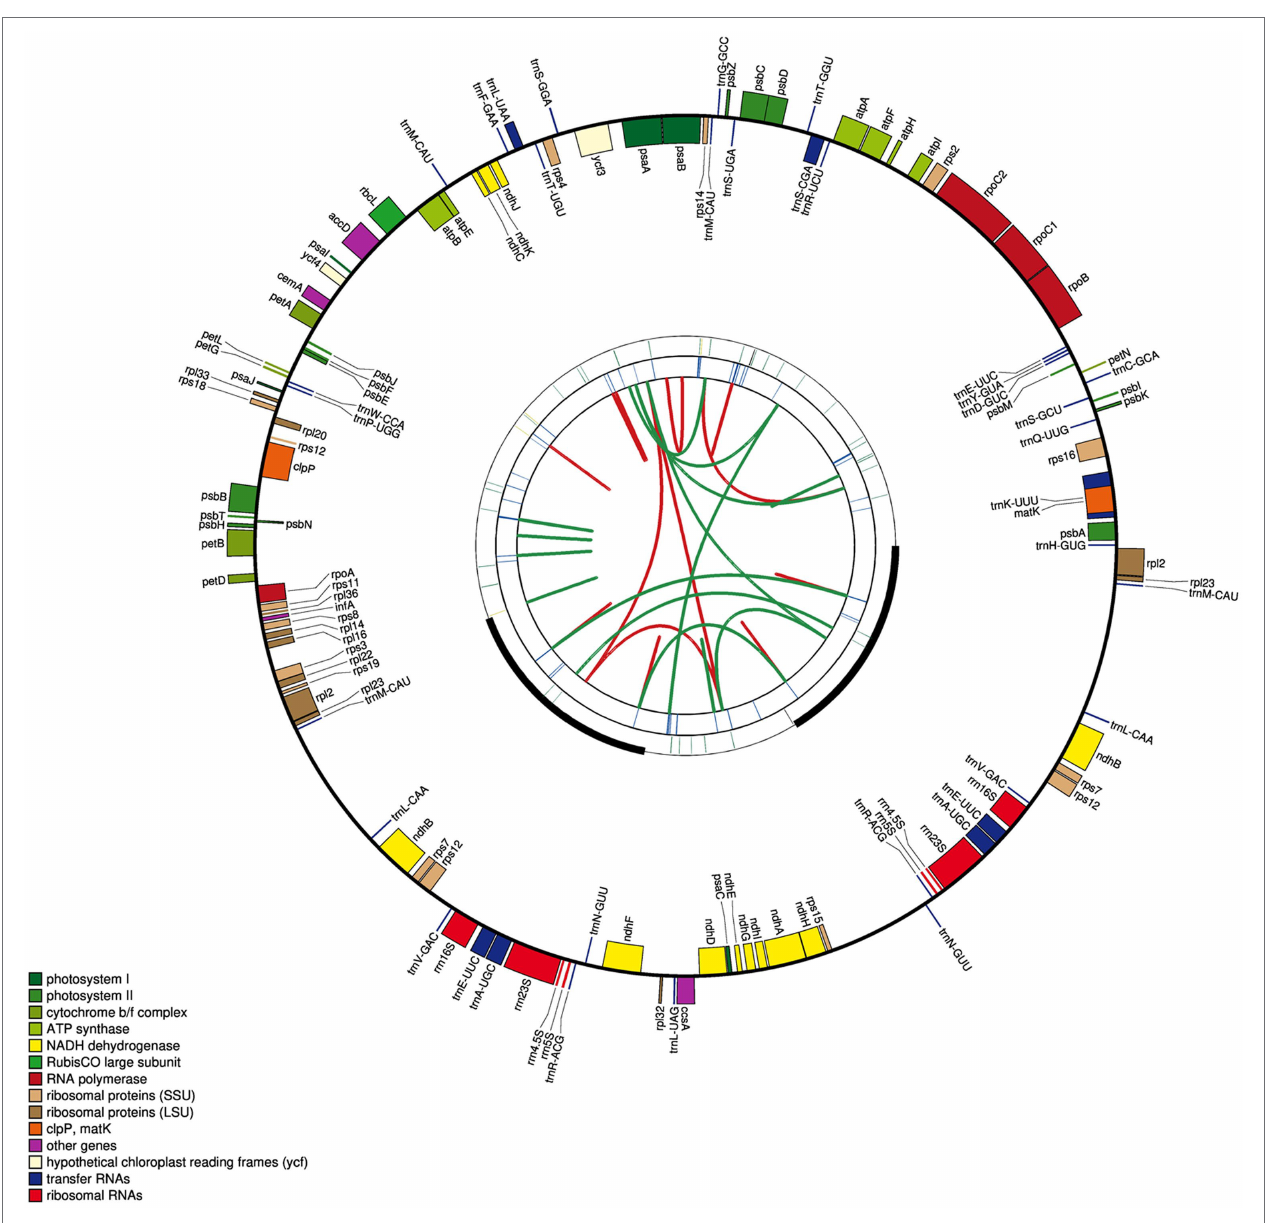
FIGURE 2 | Circular map of the E. breviscapus cp genome. There are four rings on the cp genome map. From the center to the outside, the first circle shows the forward and reverse repetitions connected by the red arc and the green arc respectively; The second circle shows the tandem repeat marked with a short bar; The third circle is the microsatellite sequence identified by MISA; the fourth circle was drawn with genemap to show the gene structure on the plastids, Genes shown outside and inside of the fourth circle are transcribed counterclockwise and clockwise, respectively; the colors of genes are distinguished according to their functional